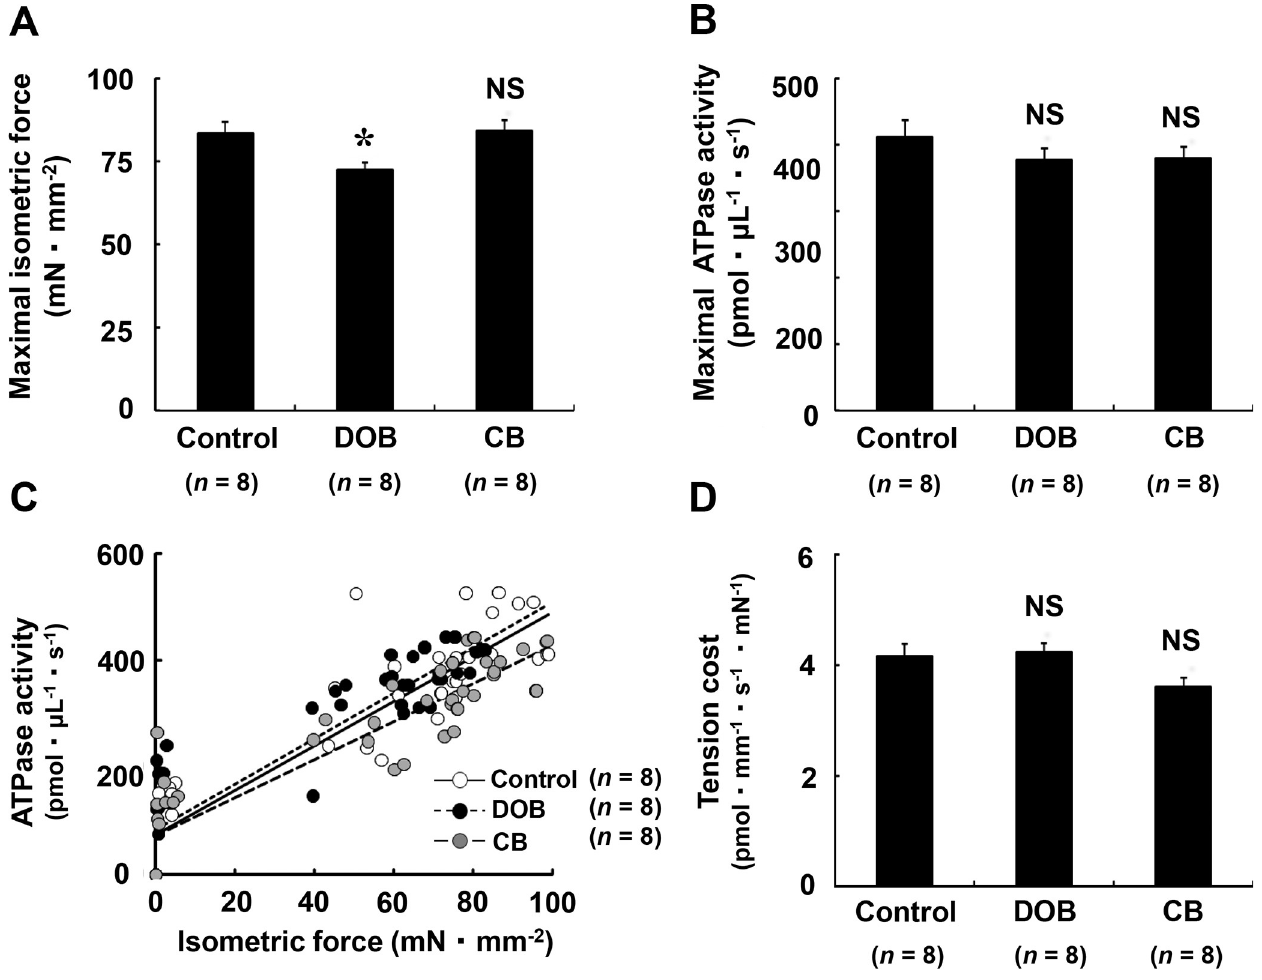
Fig 3. Effects of DOB and CB on maximal isometric force and ATPase activity and tension cost. (A) Maximal isometric force at pCa 4.6 (saturating [Ca 2+ ]) was significantly smaller in the DOB group than in the Control ( n = 8 each). (B) Maximal ATPase activity at pCa 4.6 in the DOB group or the CB group showed no significant differences from the Control ( n = 8 each). (C) Relationship between ATPase activity and isometric force in the skinned masseter preparations from the Control, DOB, and CB groups. The average ATPase activity values at pCa 6.1, 5.8, 5.5, 5.1 and 4.6 were plotted against the corresponding average force values. The data points of the three groups (open circle, Control; closed circle, DOB; gray circle, CB) were fitted by linear regression as indicated (solid line, Control; dashed line DOB; long dashed line CB). The formulae of the regression lines are y = 4.16x + 74.28, r = 0.91 (Control), y = 4.24x + 84.38, r = 0.91 (DOB), y = 3.56x + 73.37, r = 0.9 (CB), (r: correlation coefficient). Slopes of the regression lines (ATPase activity/isometric force) indicate the tension cost. (D) The average tension cost in the DOB group or the CB group showed no significant difference from the Control ( n = 8 each). CA; cardiac muscle, MA; masseter